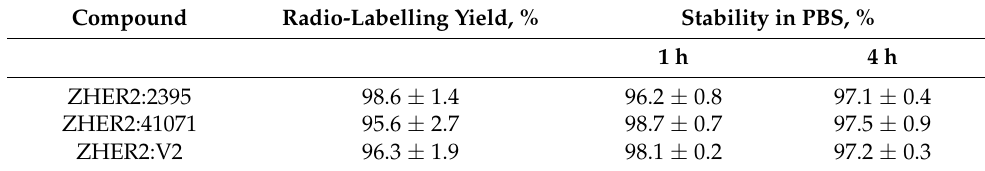
Table 1. Radiolabelling of affibody molecules with 99m Tc and stability of the conjugate. Compound Radio-Labelling Yield, % Stability in PBS, %